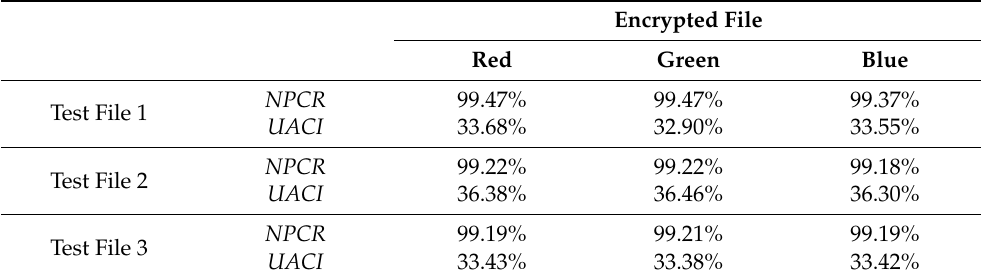
Table 5. NPCR and UACI values of the encrypted image.